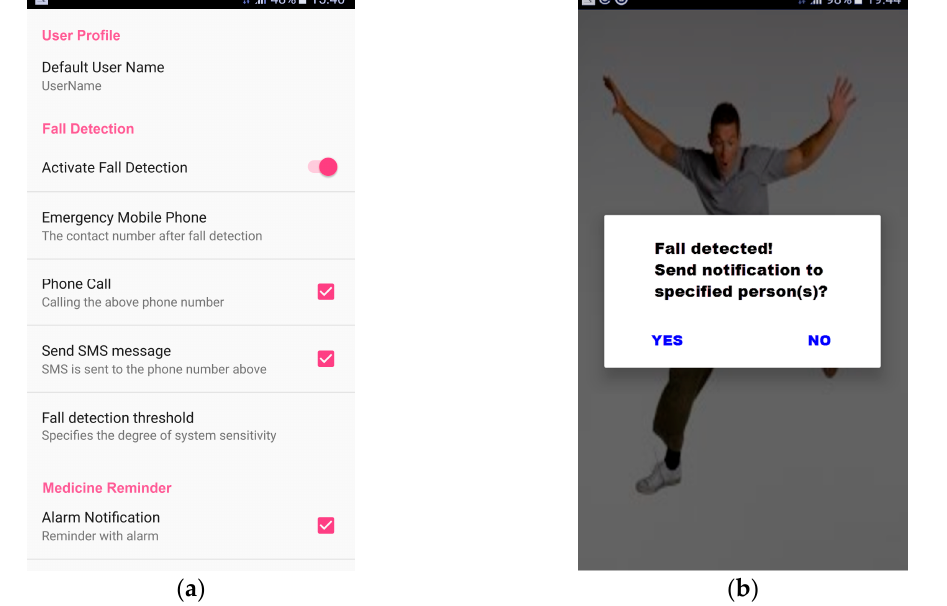
Figure 8. ( a ) Activation of fall detection service in settings screen; ( b ) Sending notification to specified person(s) confirmation message.